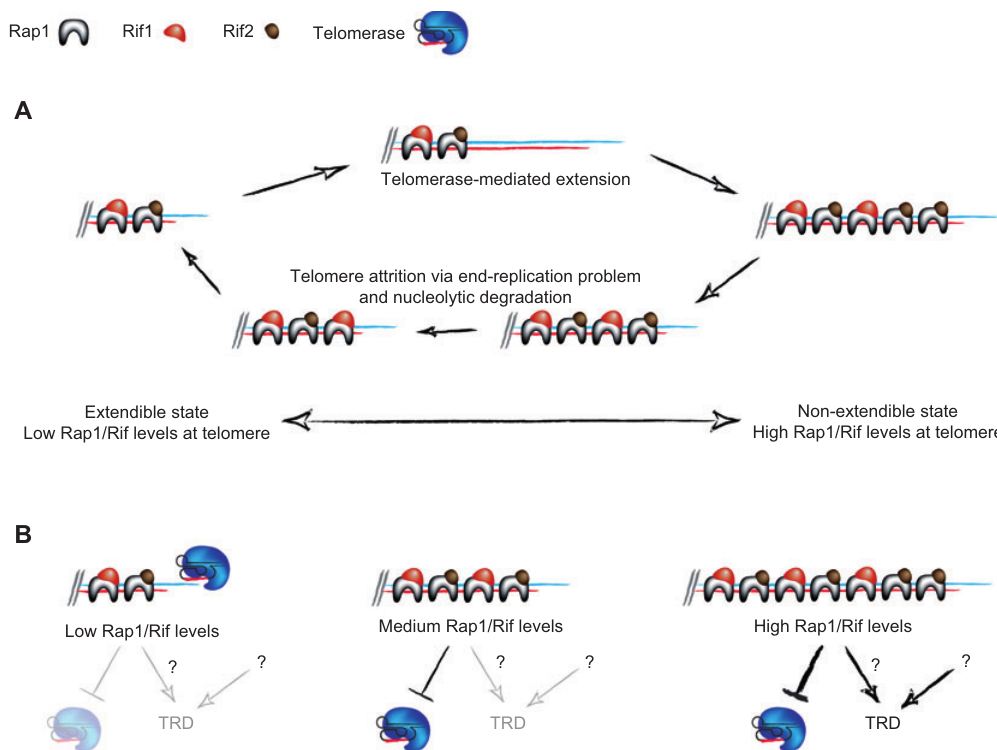
Figure 2 Regulating telomere length via a protein-counting mechanism in S. cerevisiae . (A) Telomerase activity is regulated by telomere length, which is determined by the amount of Rap1, Rif1, and Rif2 bound at a telomere. A short telomere recruits few Rap1/Rif complexes, which favors telomerase-mediated extension of the telomere. A long telomere associ- ates with many Rap1/Rif complexes, which inhibits telomerase activity. (B) While telomere-bound Rap1/Rif complexes regulate telomerase activity, it is unclear whether Rap1/Rif complexes can also mark a telomere for shortening by TRD. It is possible that TRD is regulated by a Rap1/Rif-independent